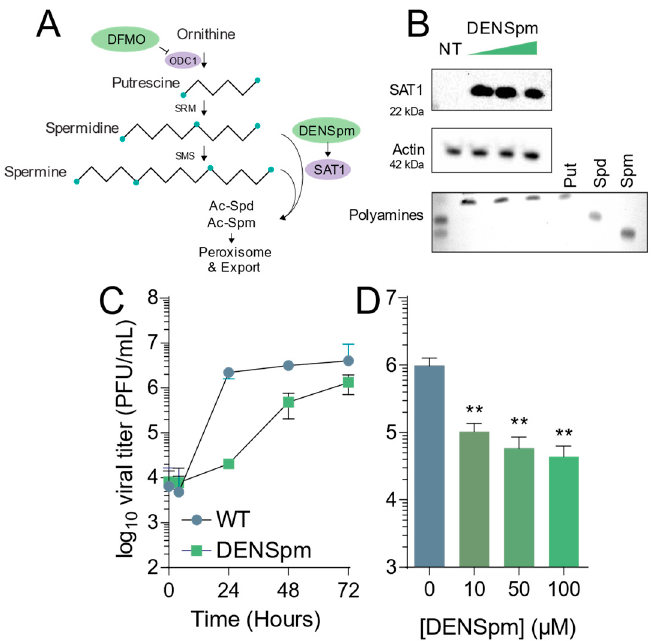
Figure 1. DENSpm induces polyamine depletion and limits Coxsackievirus B3 infection. ( A ) Schematic of the mammalian polyamine biosynthetic pathway. Pertinent inhibitors are highlighted in green, while important enzymes are highlighted in lilac. ( B ) Vero-E6 cells were treated with 10, 50, and 100 μ M DENSpm for 16 h prior to collection for Western blot for SAT1, above, and thin layer chromatography for polyamines measuring the presence of putrescine (Put), spermidine (Spm), and spermine (Spm), below. ( C ) Cells were left untreated (NT) or treated with 100 μ M DENSpm for 16h prior to infection at multiplicity of infection of 0.01 CVB3. Viral titers were determined by plaque assay at the times indicated. ( D ) Cells were treated with escalating doses of DENSpm for 16h prior to infection at MOI 0.01. Viral titers were determined at 48 hpi. ** p ≤ 0.01using Student’s t -test ( n ≥ 3), comparing treated samples to untreated controls. Error bars represent ± 1 SEM.